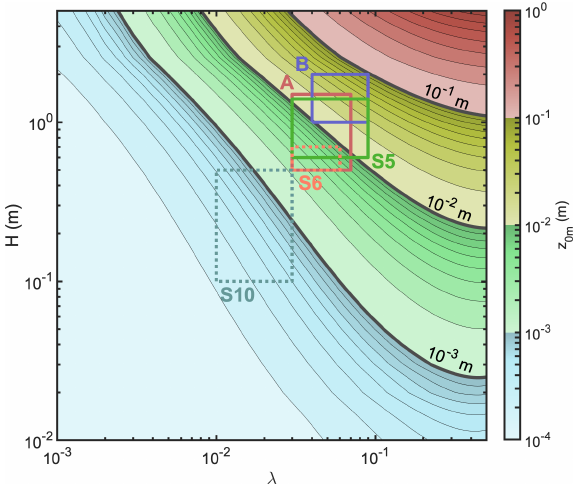
Figure A1. Estimated z 0m using the R92 model with parameterized C d (Appendix A), as a function of obstacle height H and frontal area index λ . The solid squares denote the estimated H and λ at three sites using UAV surveys. The dashed squares are estimates based on photographs taken at the end of the ablation season. See Fig. 1 for the location of each